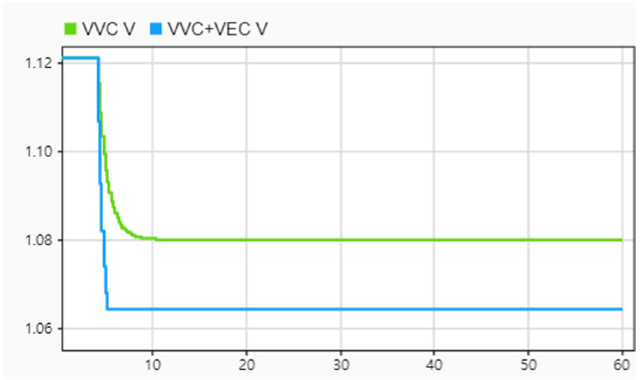
Figure 13. PCC voltage of the G1 inverter.